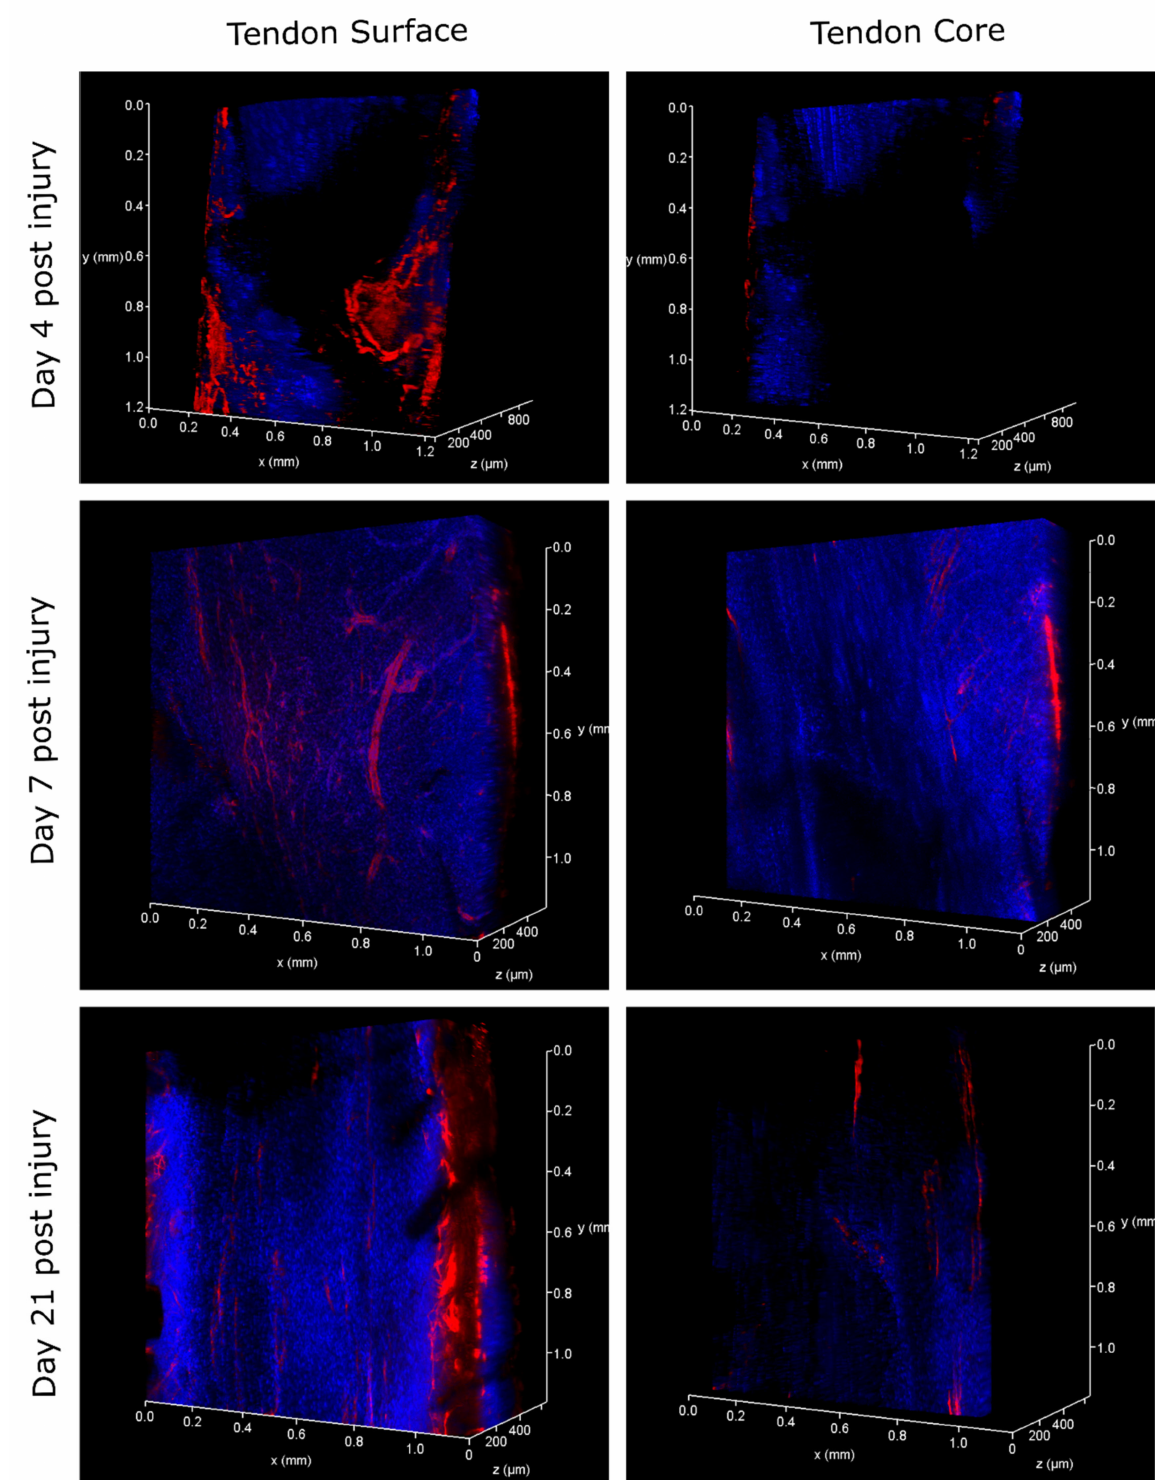
Figure 4. Three-dimensional visualisation of lesion sites in injured tendons at days 4, 7 and 21 after injury. CD146 is labelled red, with nuclei counterstained blue. At day 4 post injury, the area surrounding the lesion was mainly acellular, with CD146 expression restricted to the epitenon. By day 7, some CD146 positive-labelling could be visualised surrounding the lesion, and by day 21 CD146 expression was present within the lesion